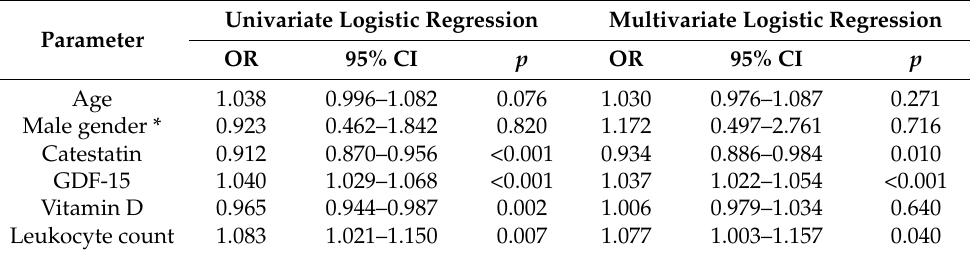
Table 4. Univariate and multivariate logistic regression analyses of independent predictors for COVID-19 fatal